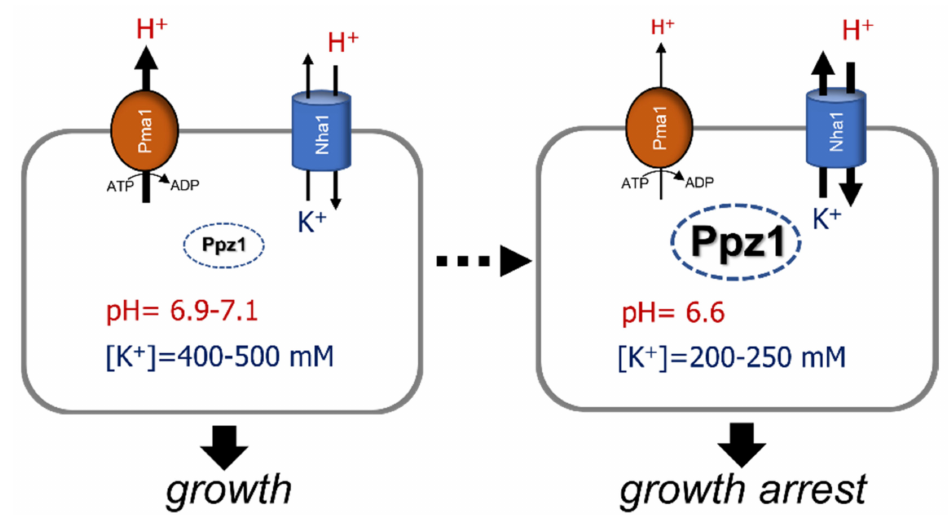
Figure 3. Proposed mechanism for altered K + and pH homeostasis derived from Ppz1 overexpression. High levels of the phosphatase would hyperactivate the Nha1 antiporter, leading to the exacerbated entry of protons and efflux of potassium. Intracellular acidification would increase further due to inhibition of the Pma1 H + -ATPase. Data for cytosolic pH and cellular K + content are taken from reference